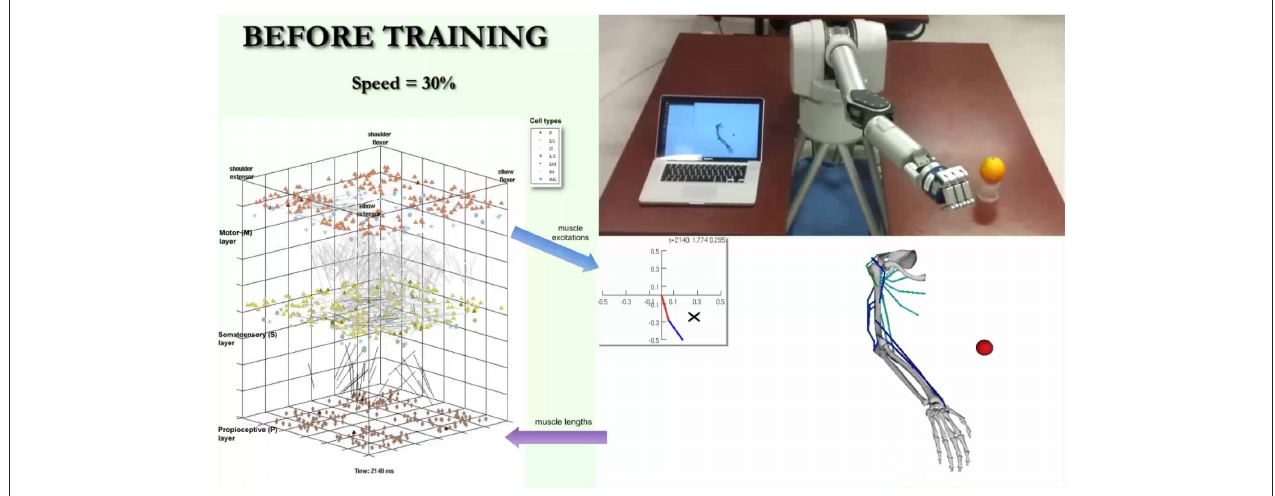
FIGURE 11 | Screenshot of video illustrating system. The video simultaneously shows the biomimetic spiking model activity, virtual arm, and robotic arm, before, during, and after training to reach a target. It illustrates the interactions between the spiking model and virtual arm, and how the robotic arm closely follows the virtual arm trajectories. The video is included in the Supplementary Material and available for download from: